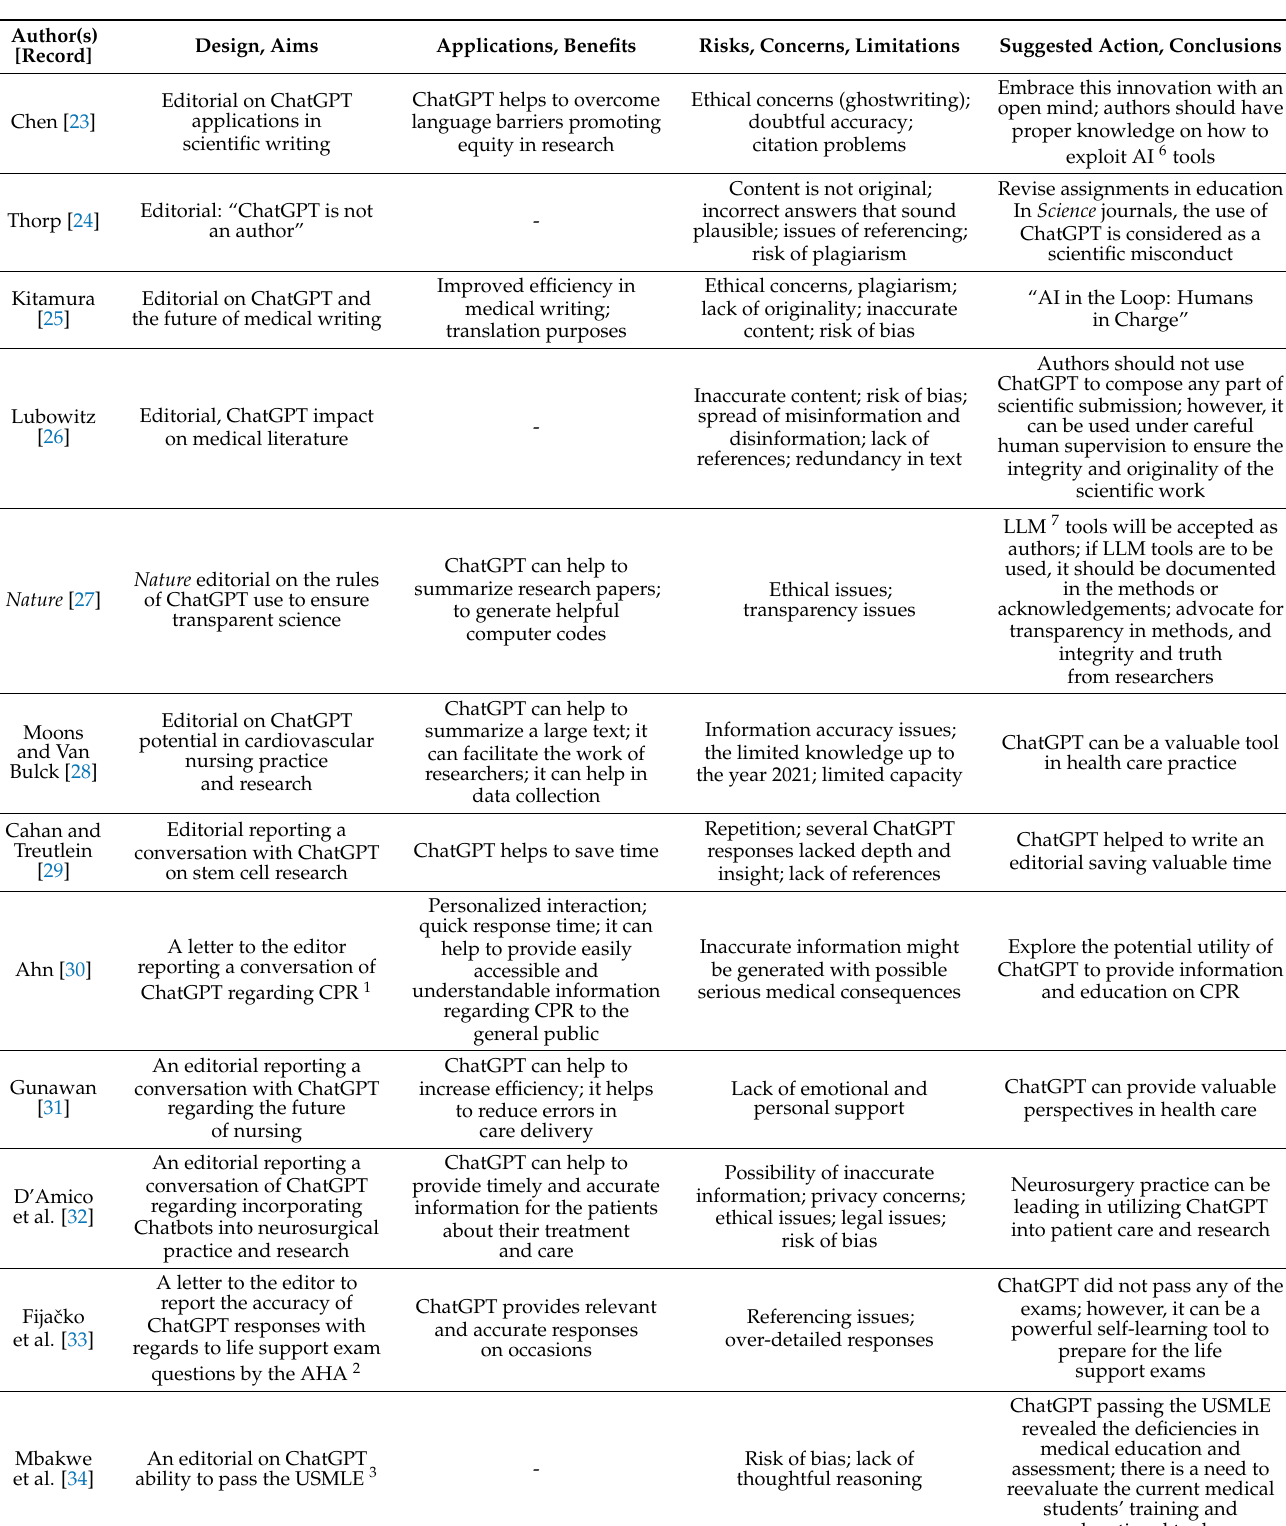
Table 1. A summary of the main conclusions of the included records comprising editorials/letters to the